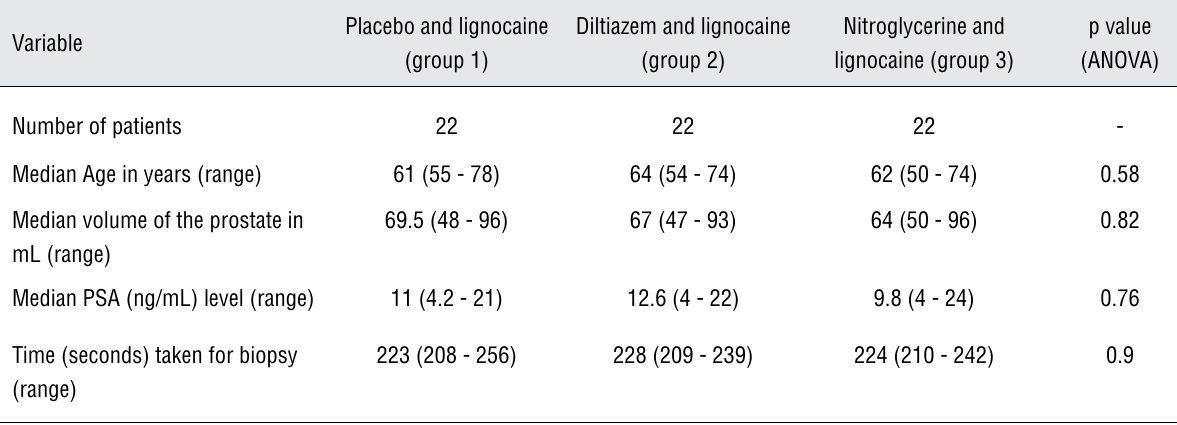
Table 1 - characteristics of the patients included in the study.